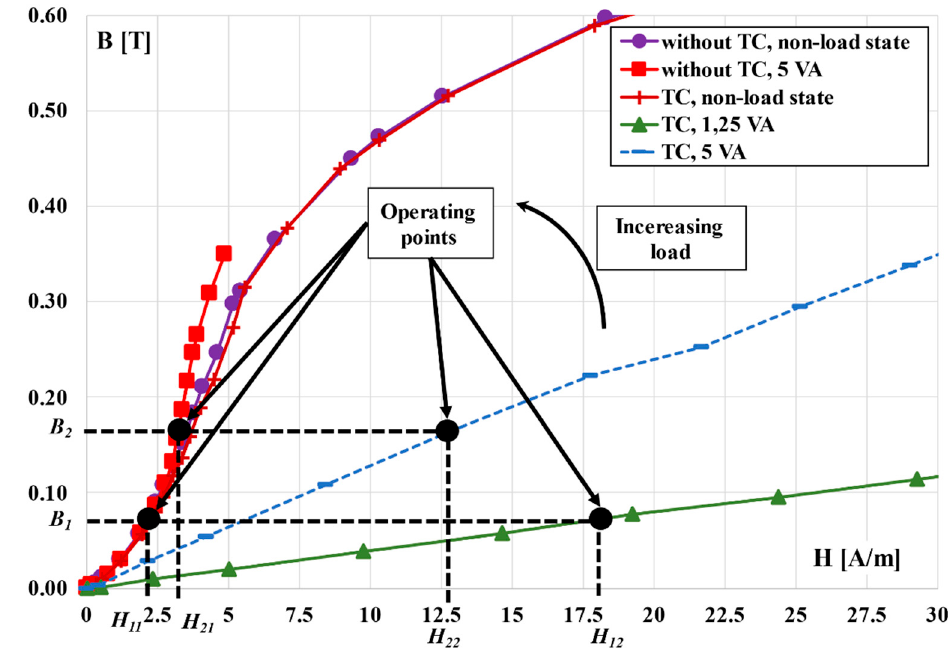
Figure 5. Equivalent magnetization curves of the TCT (abbreviation: TC—single turn correction).